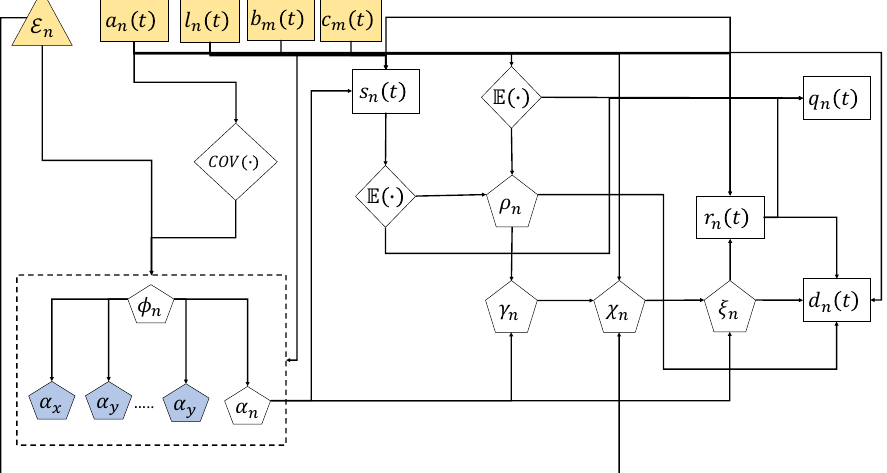
Figure 3. Block diagram of the proposed analytical model (MSAM).